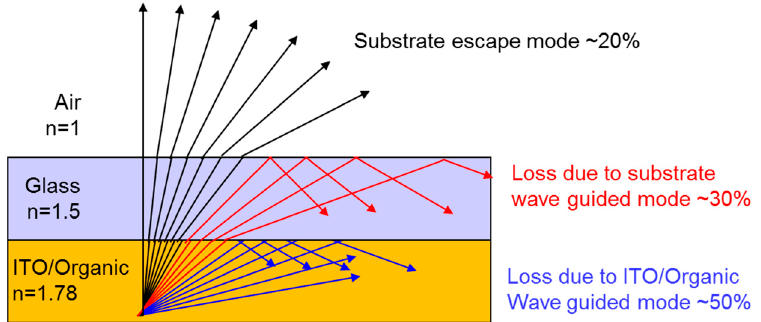
Figure 1. Schematic diagram of multi-layer OLED structure and optical ray diagram of light propagation via various modes, i.e., substrate escape, substrate wave guided mode, and ITO/Organic wave guided